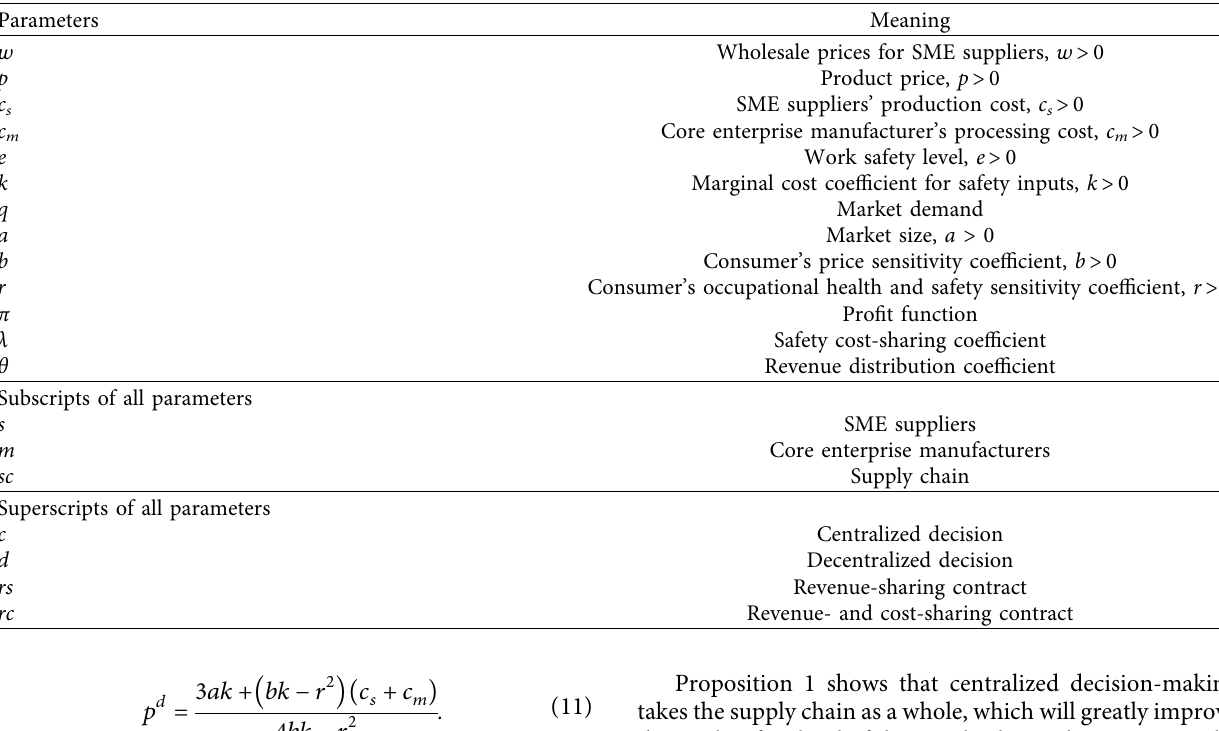
Table 1: Meaning of the relevant